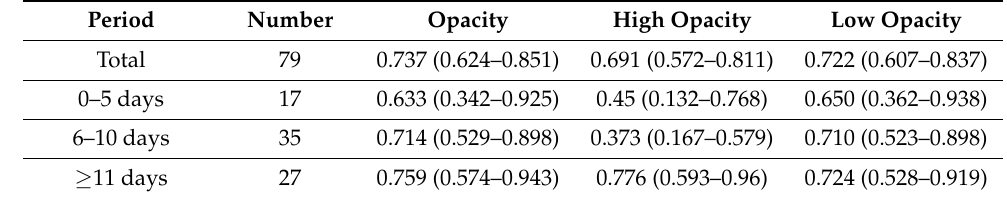
Table 3. AUC of each type of opacity volume as a predictor of oxygen demand in each period.